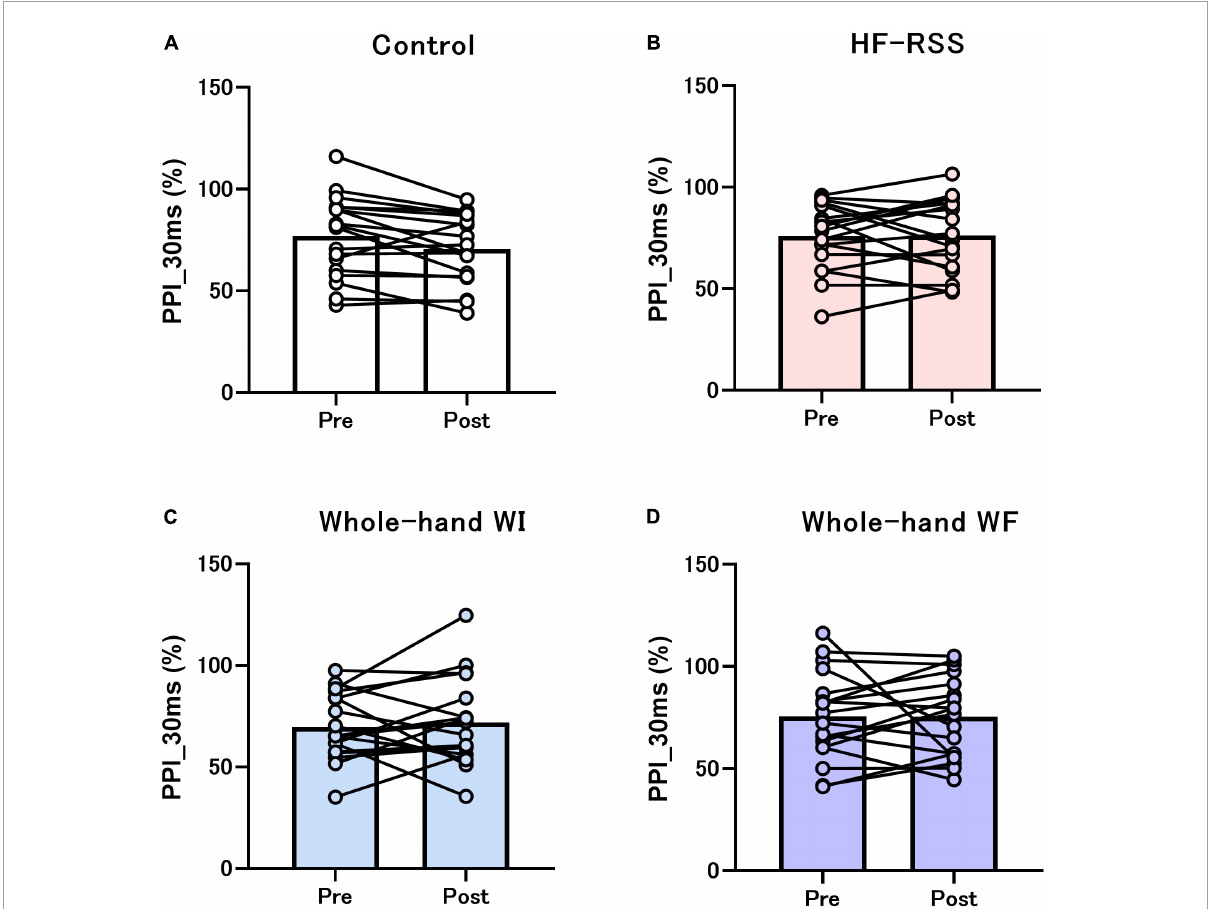
FIGURE6 PPI_30 ms of N20-P25 amplitude before and after each intervention: (A) Control, (B) HF-RSS, (C) Whole-hand WI, and (D) Whole-hand WF. Generalized linear mixed model revealed that there was no significant interaction or main effect of “intervention” and “time.” HF-RSS, high-frequency repetitive somatosensory